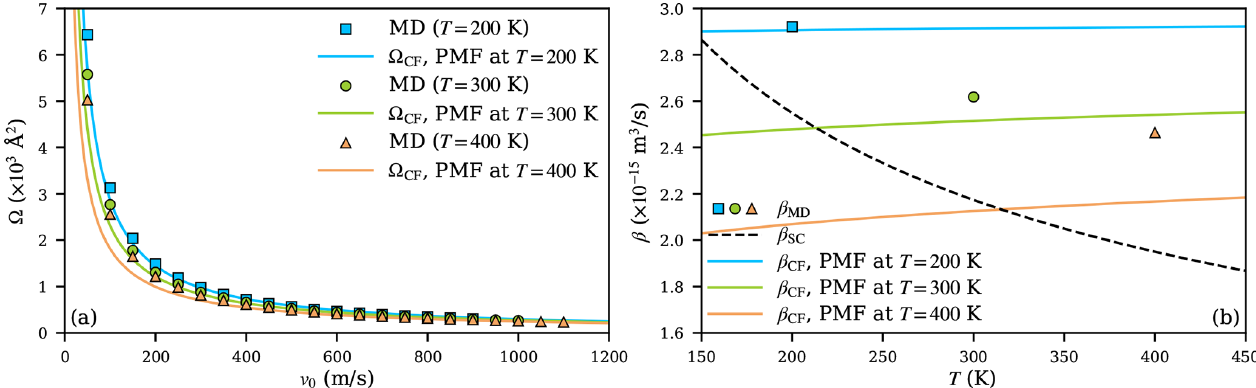
− system at temperatures 200 (blue), 300 4